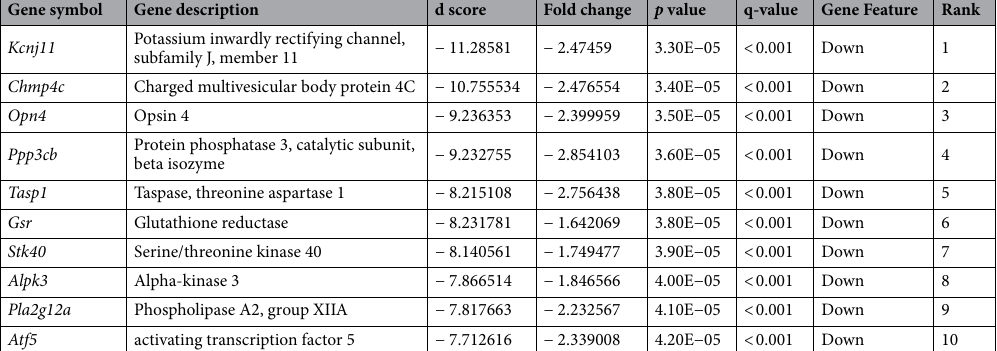
Table 1. Top 10 differentially expressed genes (in order of increasing p